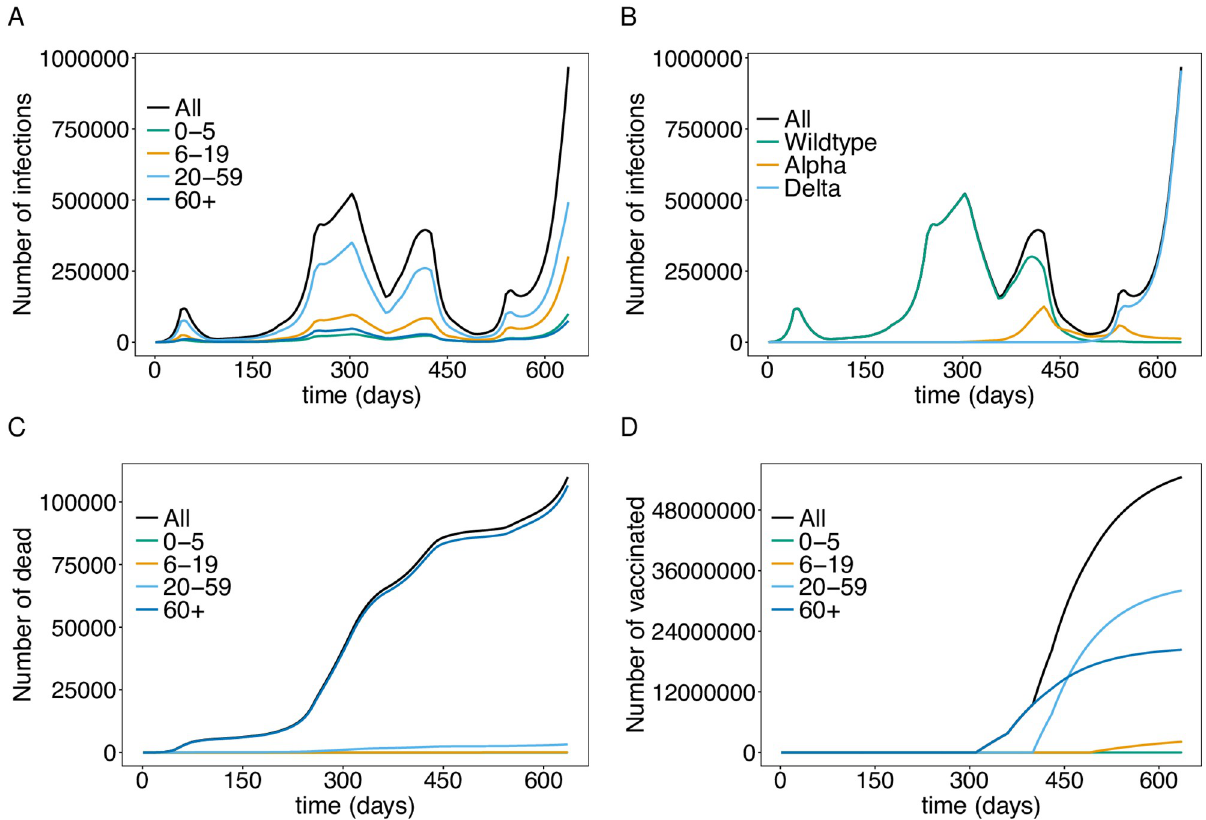
Fig 3. Epidemic dynamics in Germany until fall 2021. The total numbers of infected (latent ( E ), prodromal ( P ), fully- ( I ), and late-infectious ( L ) individuals) stratified by age group (A) or viral variants (B). (C) The total numbers of dead individuals ( D ) stratified by age group. (D) Vaccination progress by age group. The parameters used for the simulations are listed in S1 to S11 Tables. Simulation time is from day t = 0 to day t =